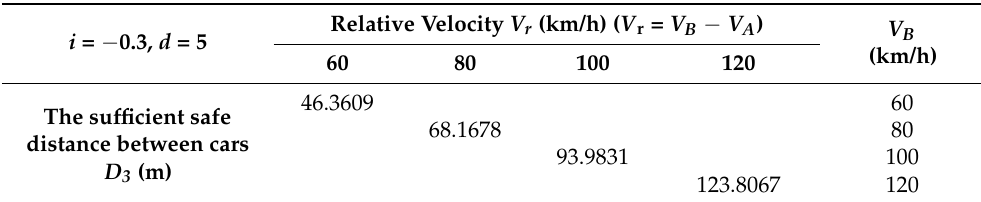
Table 10. The sufficient safe distance D 3 based on V B between 60 and 120 km/h when i = − 0.3 and d =